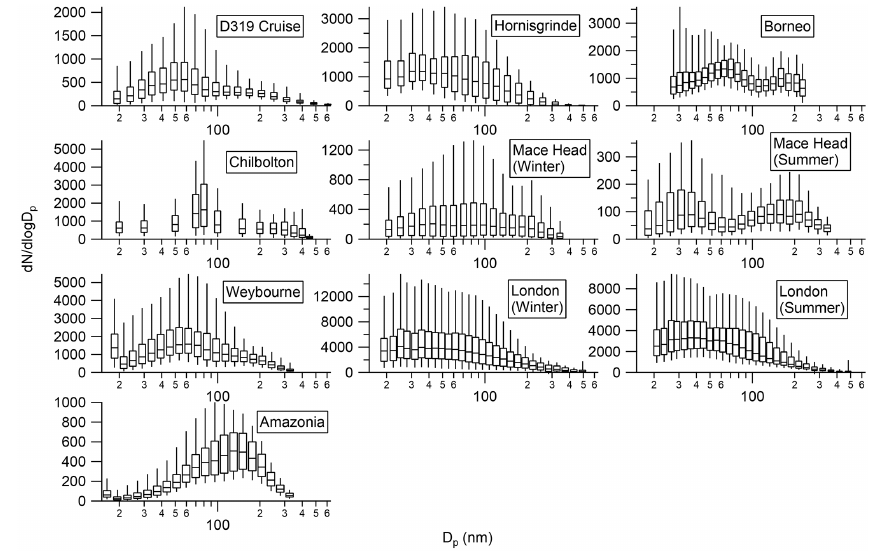
Figure 2. Size distribution box-and-whisker plots showing the median, interquartile ranges and 5th and 95th percentile size distributions for each measurement